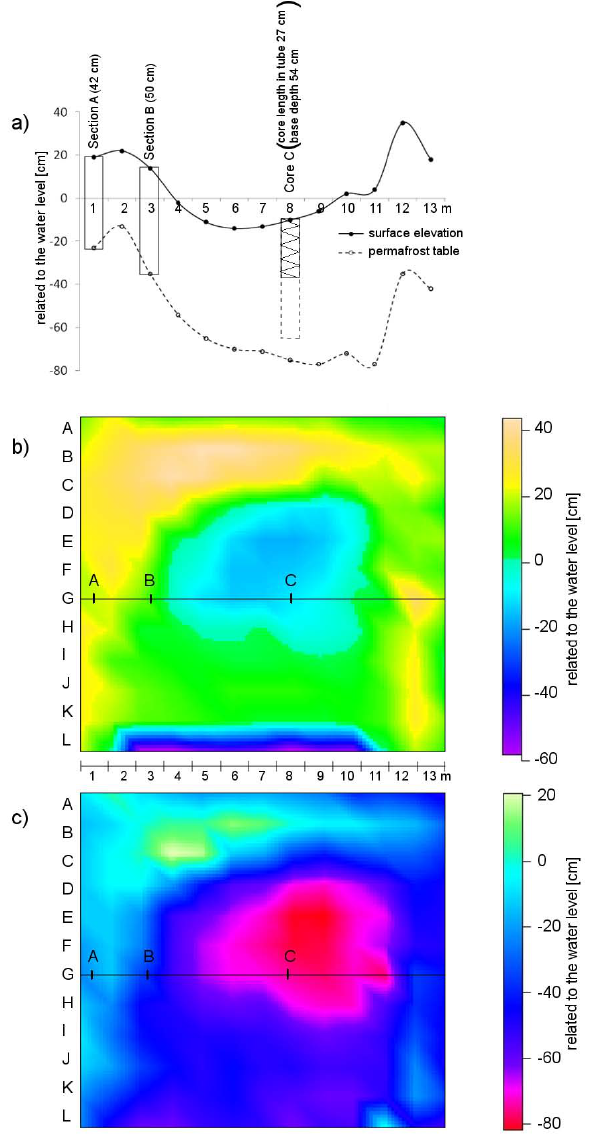
Fig. 2. The 07-SA-LY polygon was divided into a 12m (A–L) by 13m (1–13) grid of square metre plots. A surface transect, from which all three profiles were taken, was positioned in the grid along line G. (a) Surface elevation and thaw depth relative to the water level in the polygon pond along the surface transect (Transect G), illustrating the differences between a shallow thawing depth below the rims, in contrast to conditions beneath the pond. (Note: Core C was highly compressed, being reduced from 54 to 27cm during sampling.) (b) The elevation of the ground surface, relative to the water level in the pond. (c) The elevation of the permafrost table, relative to the water level in the pond.